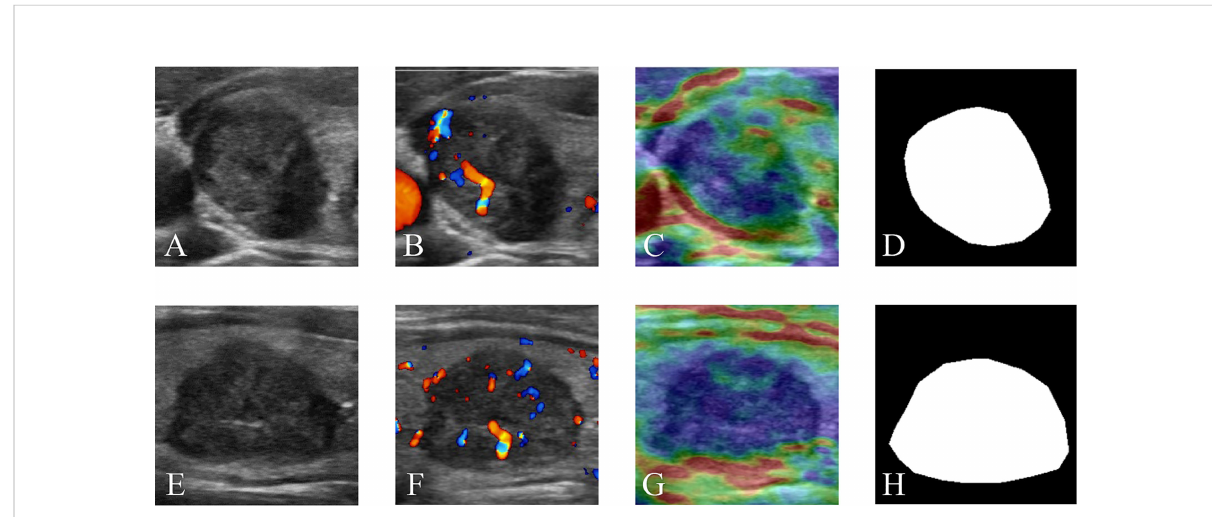
FIGURE 2 Multimodal ultrasound images of a thyroid nodule in the right lobe of a 65-year-old female patient with a pathologically proven papillary carcinoma. (A) GSU, (B) CDFI, (C) SE, and (D) Mask ultrasound images in transverse section. (E) GSU, (F) CDFI, (G) SE, and (H) Mask ultrasound images in longitudinal section. GSU, grayscale ultrasound; CDFI, color Doppler fl ow imaging; SE, strain elastography; Mask, region of interest